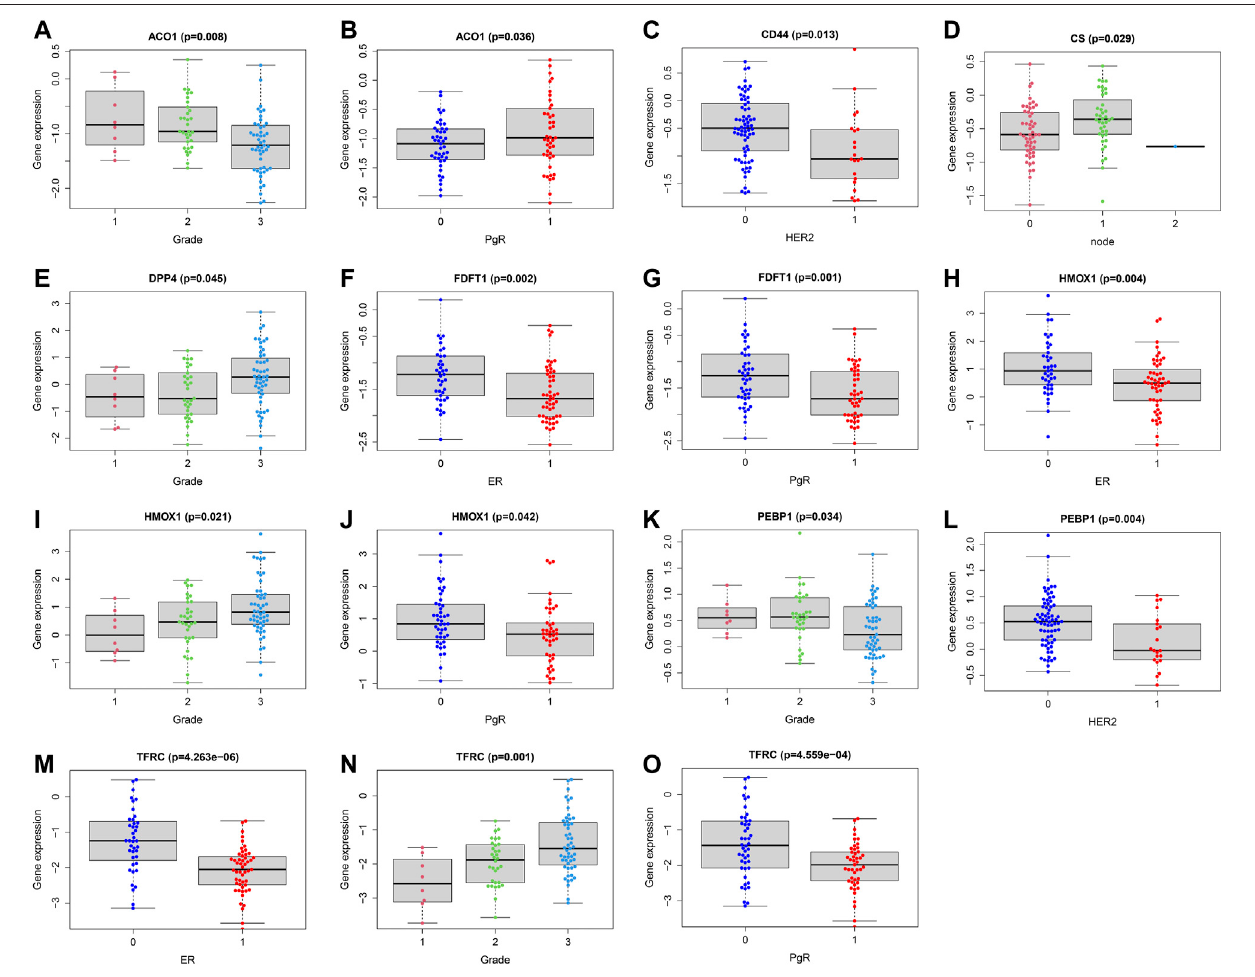
FIGURE 5 | Correlations analysis between FRG and patients ’ clinical characteristics. Correlations between ACO1 and tumor grade (A) and PgR (B) . Correlations between CD44 and HER2 (C) . Correlations between CS and lymph nodes (D) . Correlations between DPP4 and tumor grade (E) . Correlations between FDFT1 and ER (F) and PgR (G) . Correlations between HMOX1 and ER (H) , tumor grade (I) and PgR (J) . Correlations between PEBP1 and tumor grade (K) and HER2 (L) . Correlations between TFRC and ER (M) , tumor grade (N) and PgR (O) . ER (1 (cid:1) positive; 0 (cid:1) negative); PgR (1 (cid:1) positive; 0 (cid:1) negative); HER2 (1 (cid:1) positive; 0 (cid:1) negative); node status (1 (cid:1) positive; 1 (cid:1) 2 or more nodes+; 0 (cid:1) negative); size (1 (cid:1) ≤ 2 cm; 2 (cid:1) 2-5 cm; 3 (cid:1) > 5 cm; 4 (cid:1) any size with direct extension to chest wall or